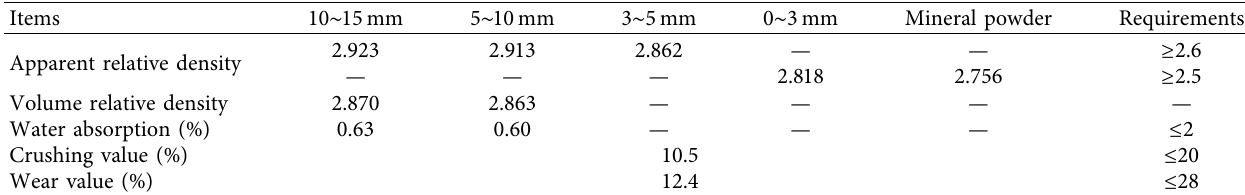
Table 8: Test results of physical properties of SMA-13